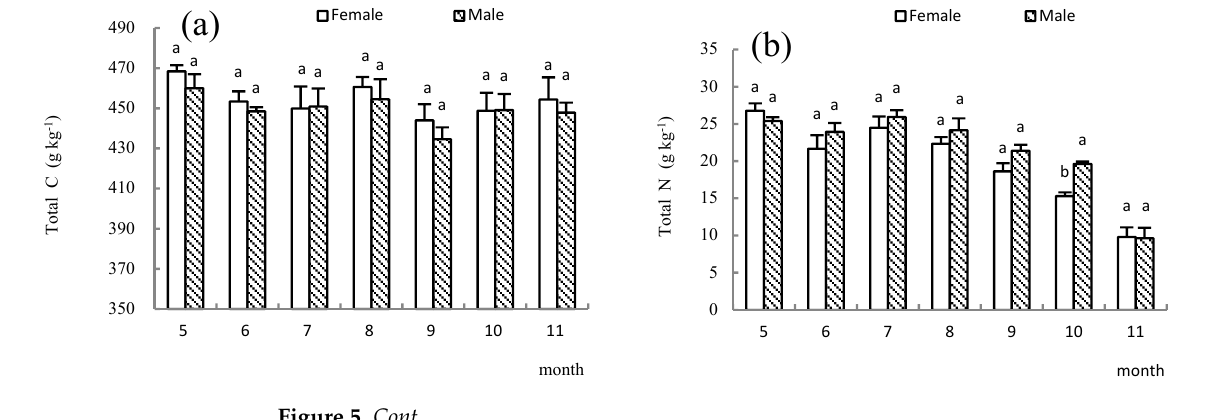
Figure 4. Monthly dynamic of C/N ( a ), C/P ( b ), N/P ( c ) ratios in different organs of male plants of F. velutina . Note: Means of different months not sharing the same letter indicated significant differences at an alpha level of 0.05, according to an LSD test.